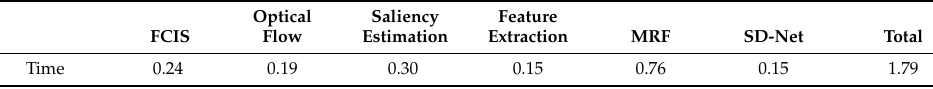
Table 12. Running times in seconds per frame